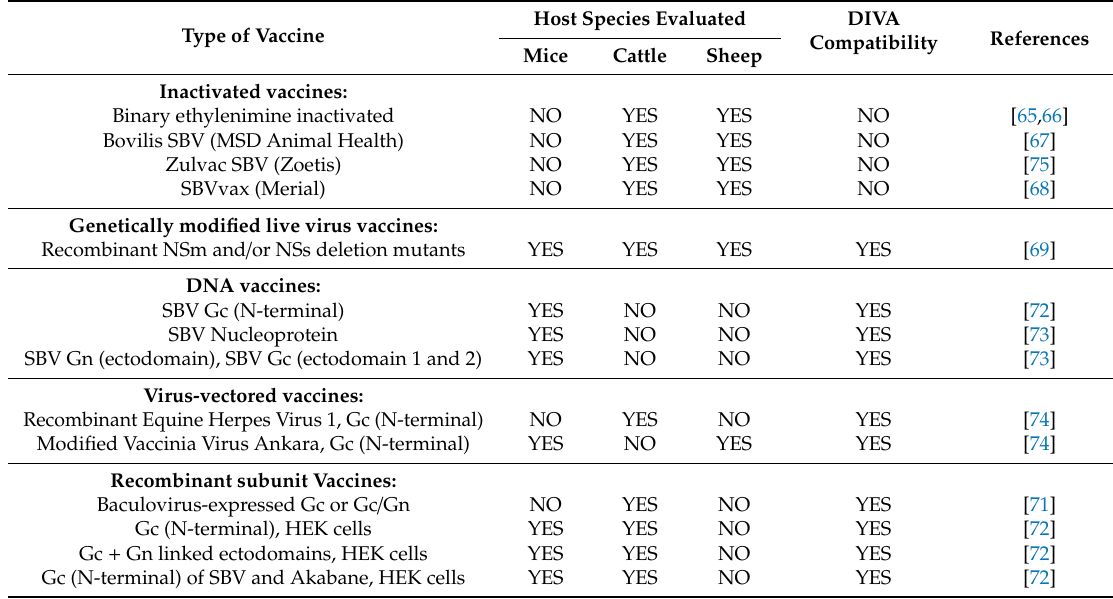
Table 1. Summary of SBV Vaccines and SBV Vaccine